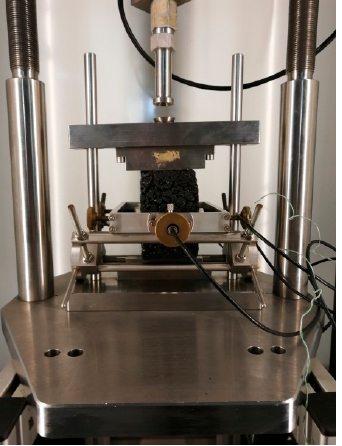
Figure 6. Indirect tensile test. Figure 6. indirect tensile test.